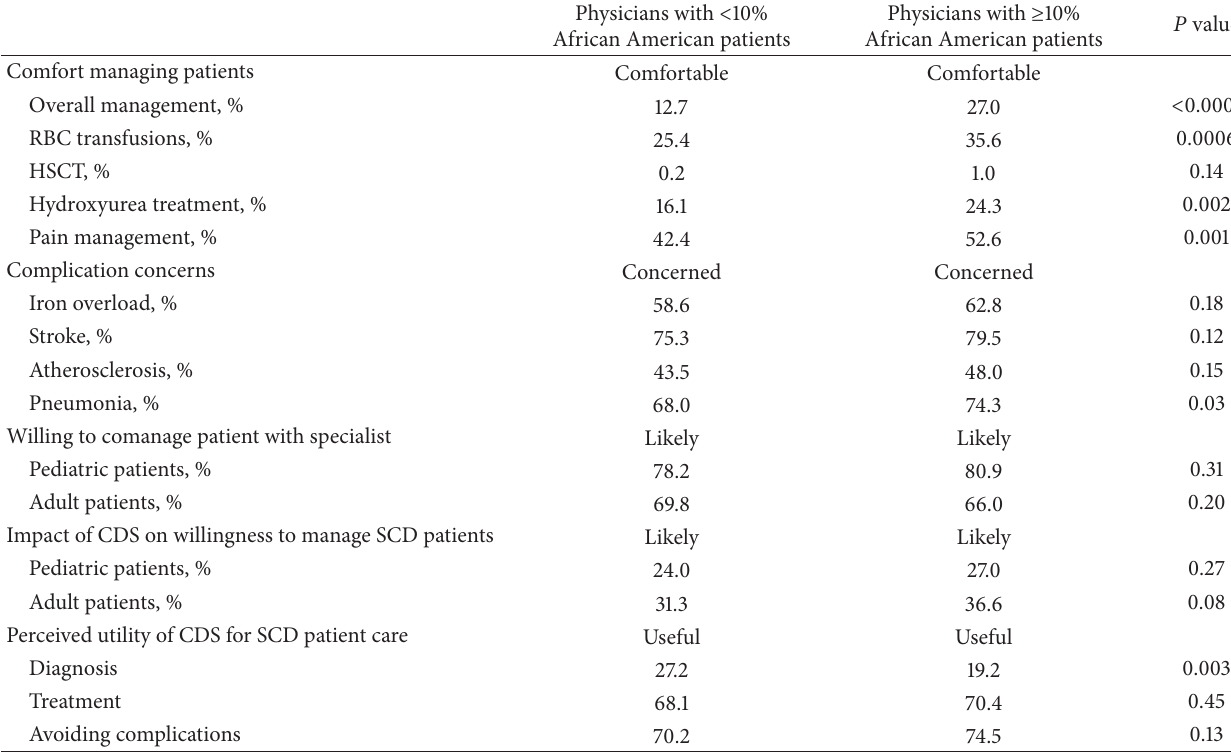
Table 3: Physician perceptions of SCD by percentage of patients who are African American.